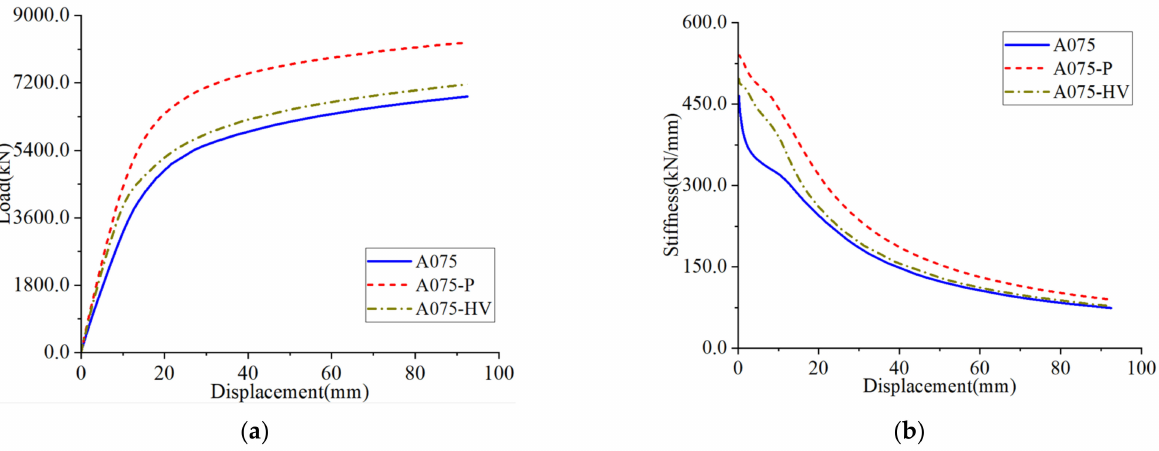
Figure 15. Numerical simulation results of different SPSWs. ( a ) Load–displacement curve. ( b ) Stiffness–displacement